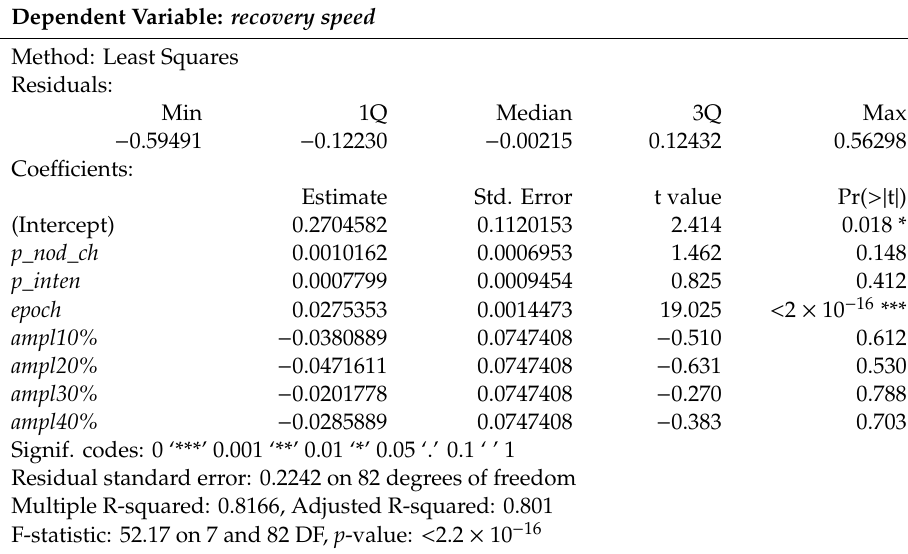
Table 9. Regression model for recovery speed , instance rl1889.